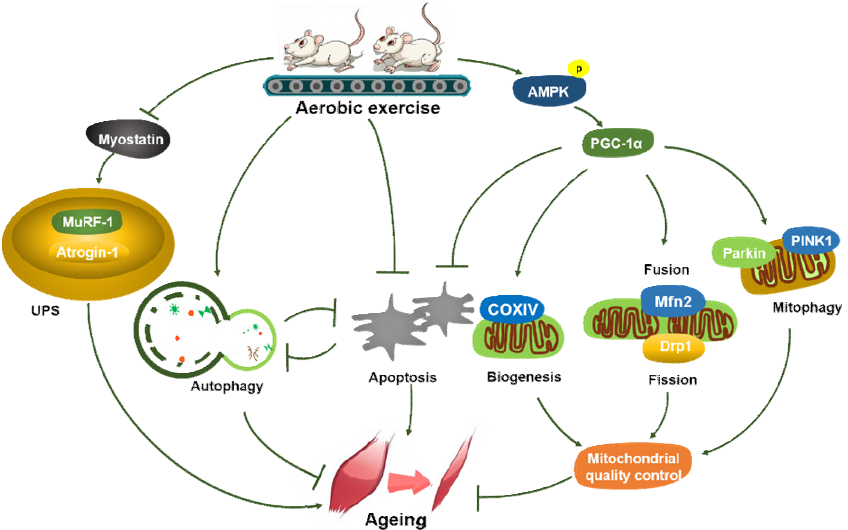
Figure 7. Lifelong aerobic exercise alleviates the initiation and progression of sarcopenia by acti- vating autophagy/mitophagy and inhibiting excessive apoptosis to improve mitochondrial quality control and suppress UPS-mediated protein degradation via the AMPK/PGC-1α signaling path-